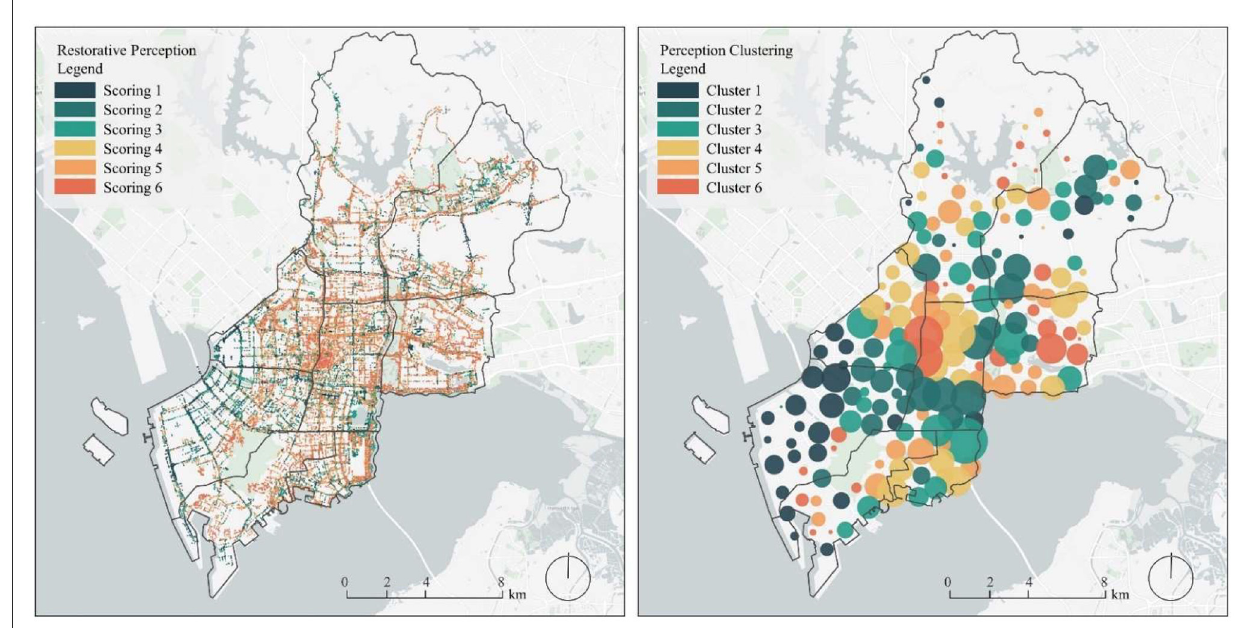
FIGURE4 Distribution of restorative perception scores on street (left) and restorative perception clustering with different scores (right) .